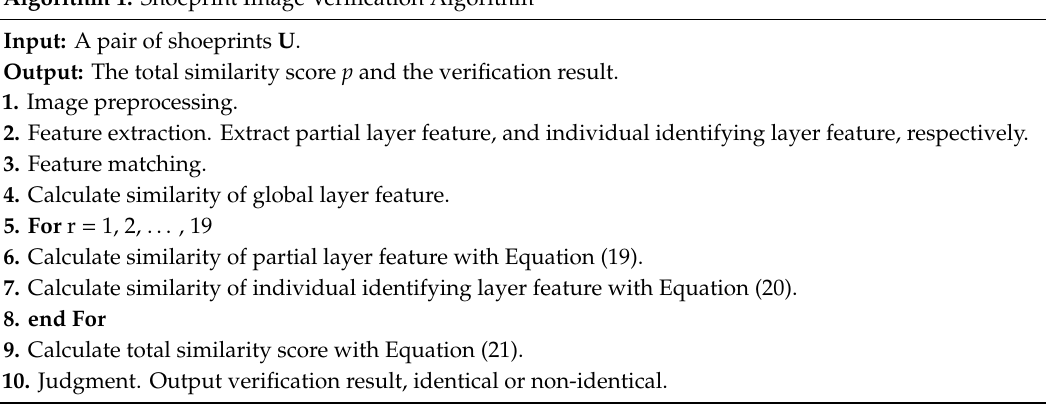
Algorithm 1. Shoeprint Image Verification